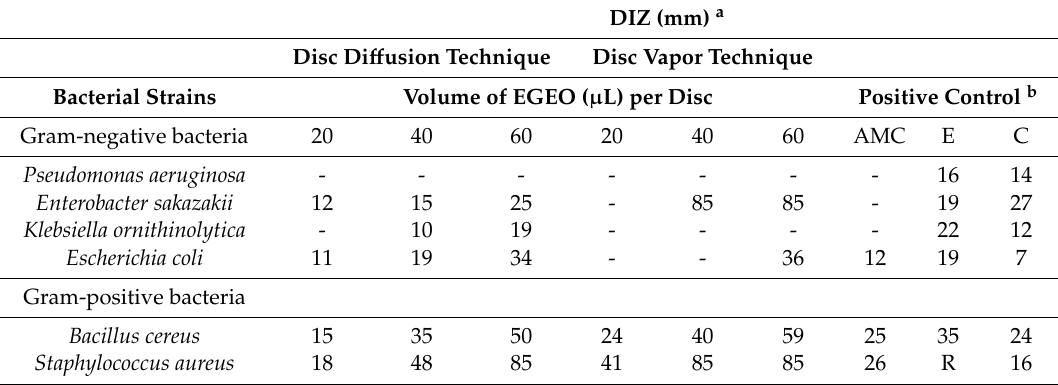
Table 3. Susceptibility of bacterial strains to Eucalyptus globulus essential oil and to classic antibiotics (positive